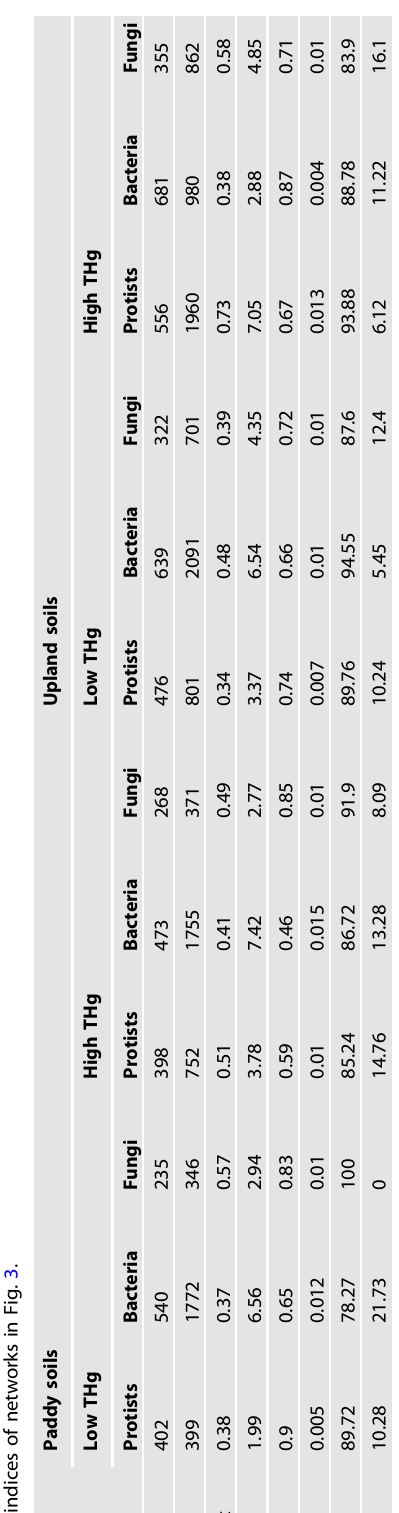
Table 2). For example, protistan taxa including Sphaeropleales, Chlamydomonadales, Desmodesmus, Staurosira, and Craticula showed more links with bacterial taxa in polluted